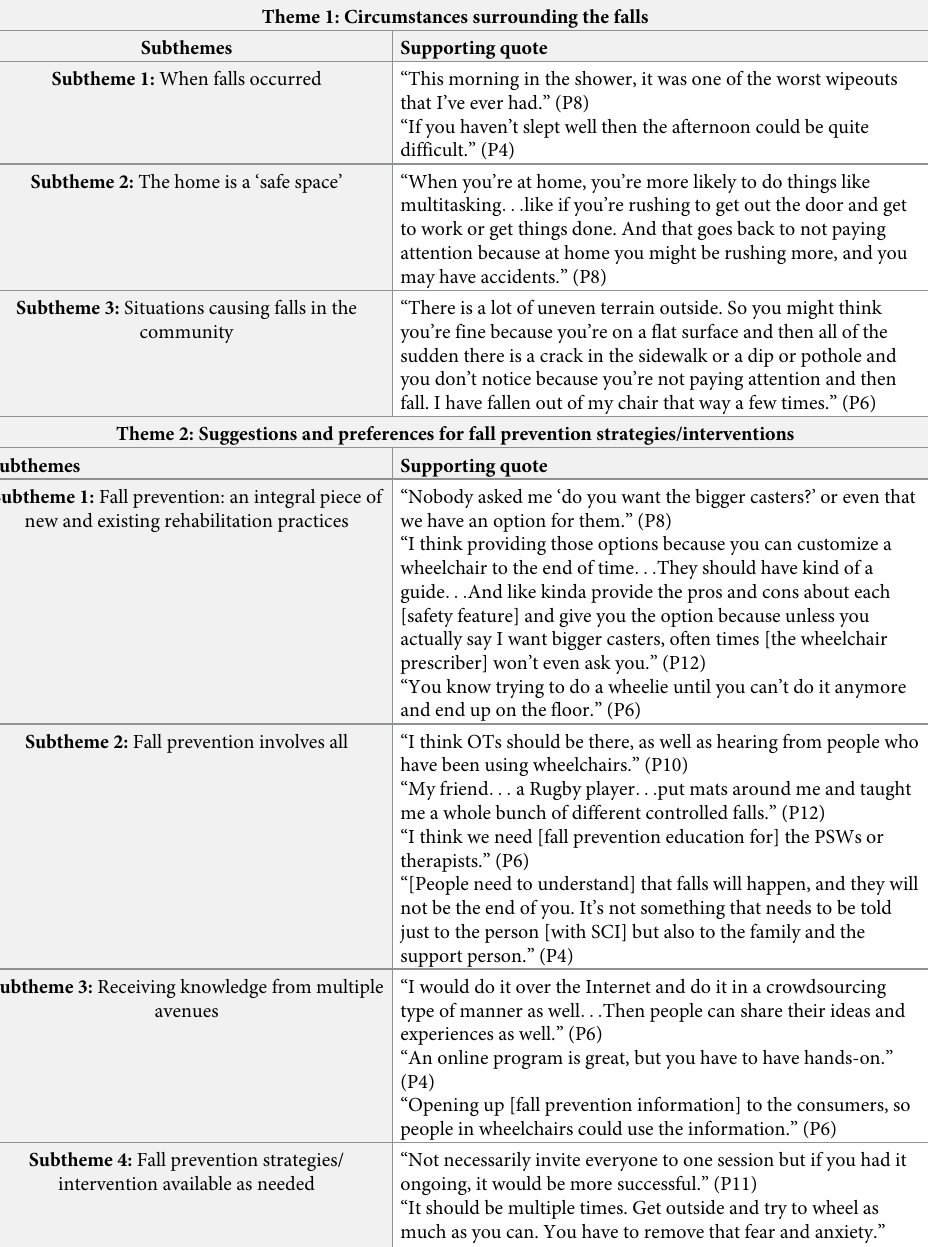
Table 4. Themes, subthemes, and supporting